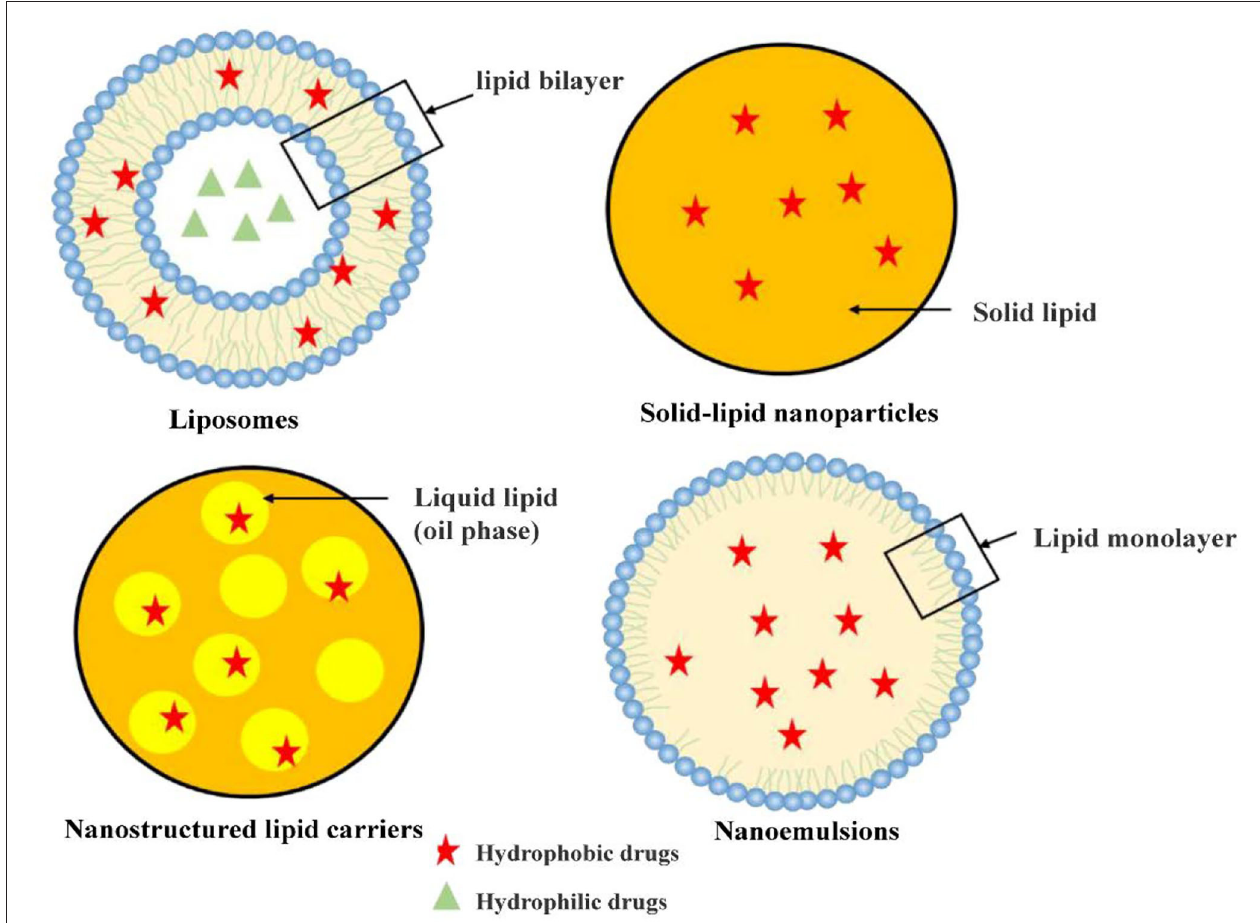
FIGURE 2 | The classification of nanocarriers based on lipids or